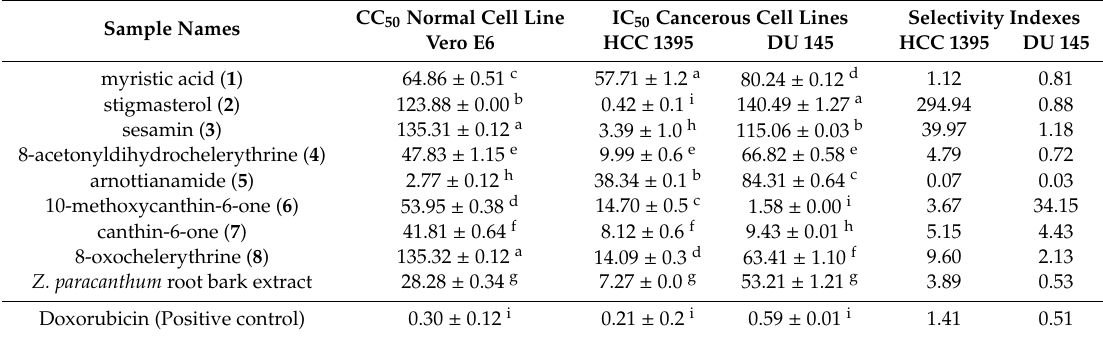
Table 2. CC 50 / IC 50 ( µ g / mL) and SI values for di ff erent samples against selected cell